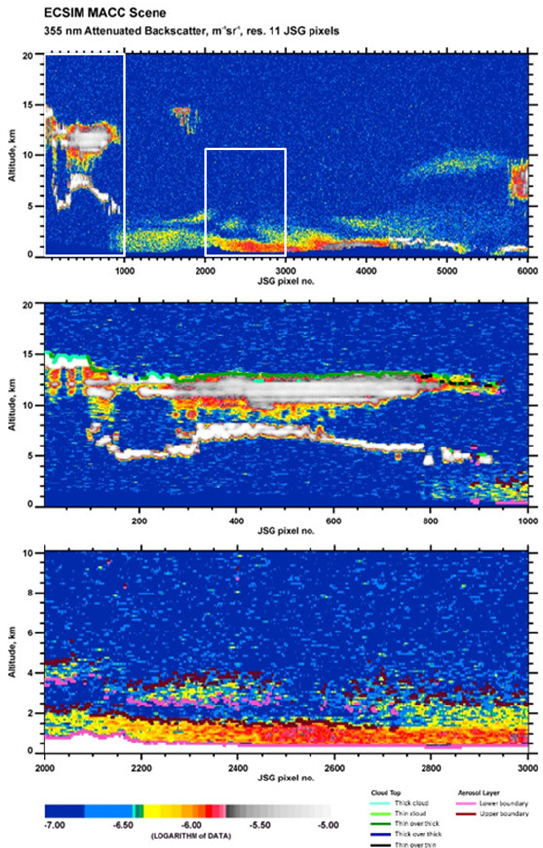
Fig. 1 Time-height contour plot of simulated ATLID attenuated backscatter (upper panel, full frame, JSG pixel no. 0-6000) overlaid with cloud top heights (middle panel, JSG pixel no. 0-1000) and aerosol layer boundaries (lower panel, JSG pixel no. 2000-3000) retrieved for 11 JSG pixels horizontal resolution with the A-LAY processor for the MACC scene. The cloud class in the middle panel is color-coded (see